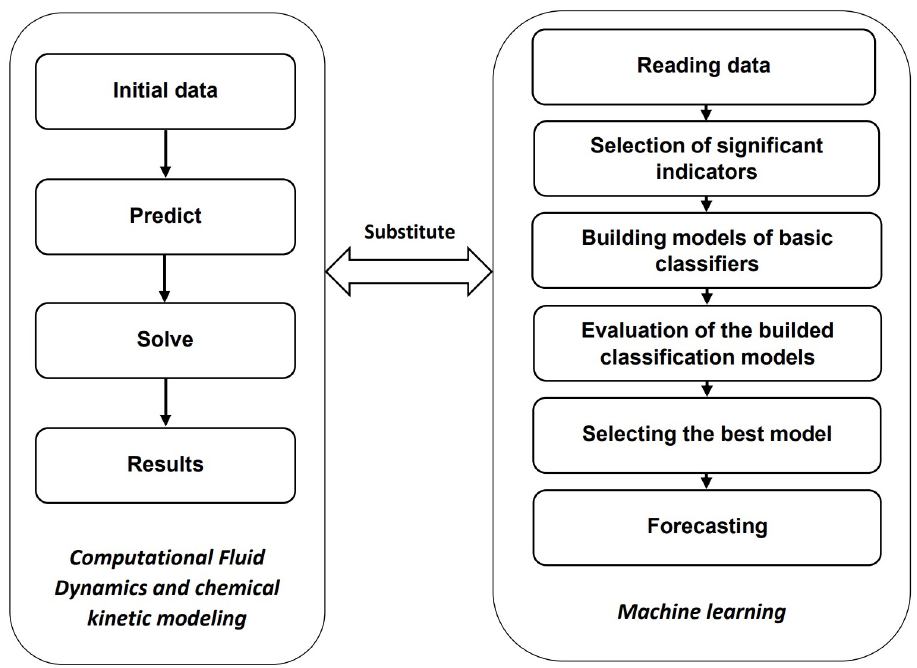
Figure 11. Flowchart to present the proposed